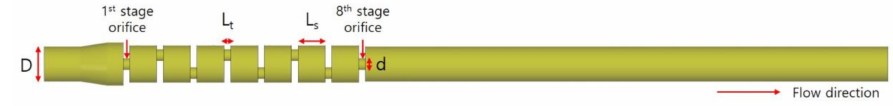
Figure 6. Schematic diagram of the eight-stage orifice and the connecting